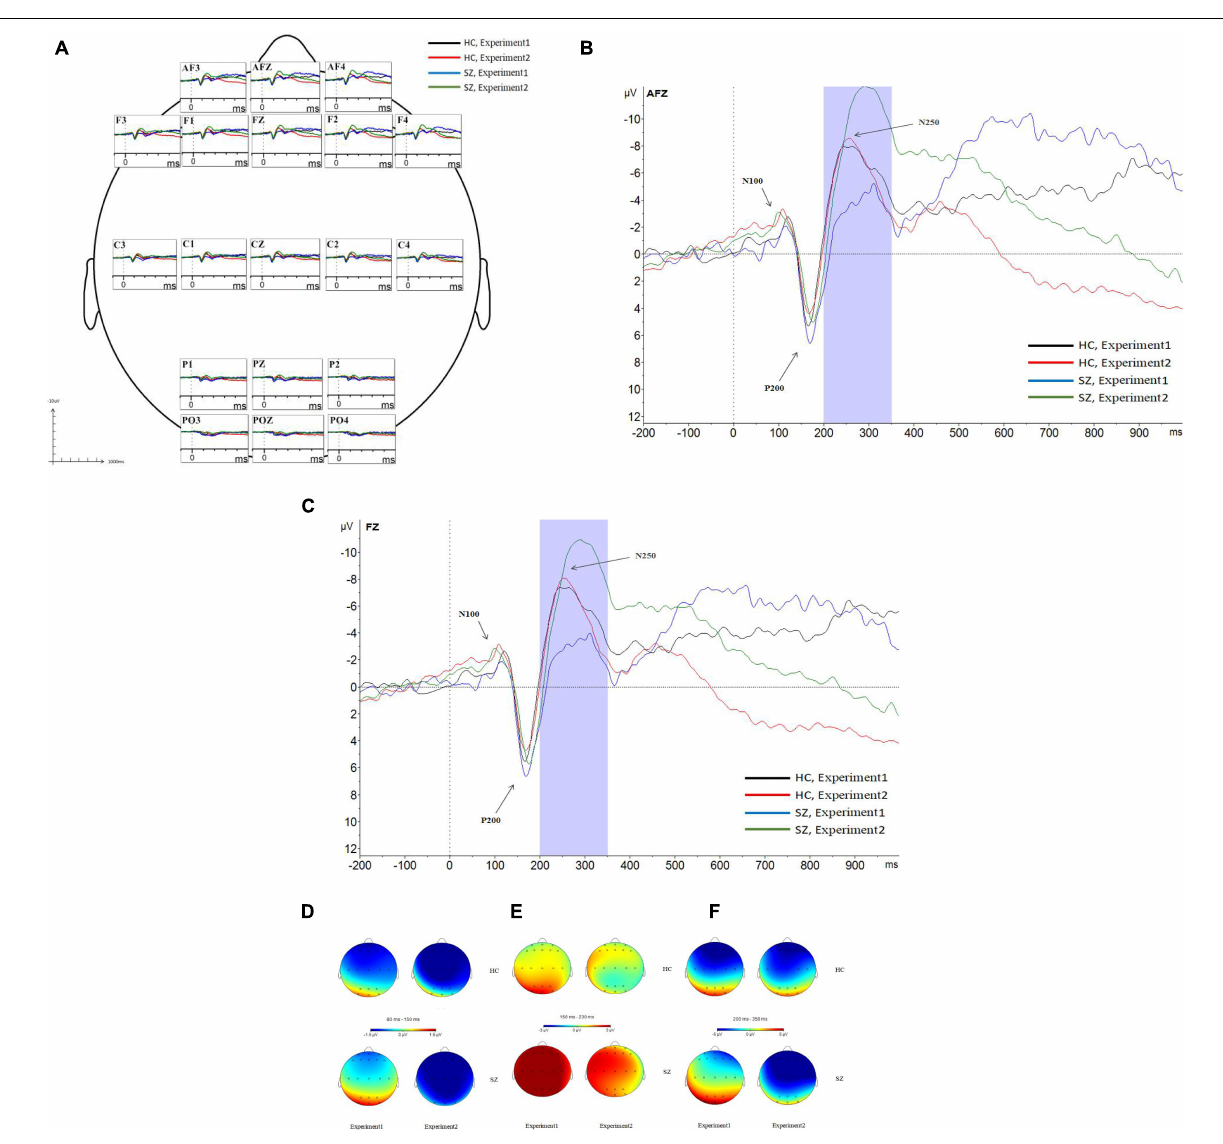
p = 0.901, η 2 = 0.000), and group × site was not significant ( F 1 , 95 = 0.717, p = 0.451, η 2 =